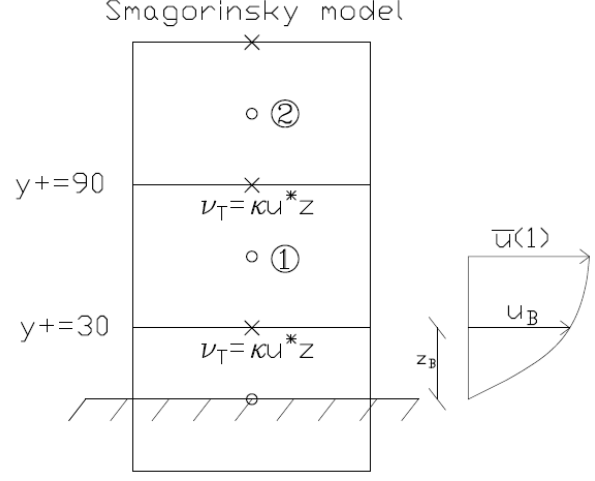
Figure 4. Discretization of the vertical cells outside the buffer layer for the Smagorinsky model. In Table 1 there is a synthetic description of the